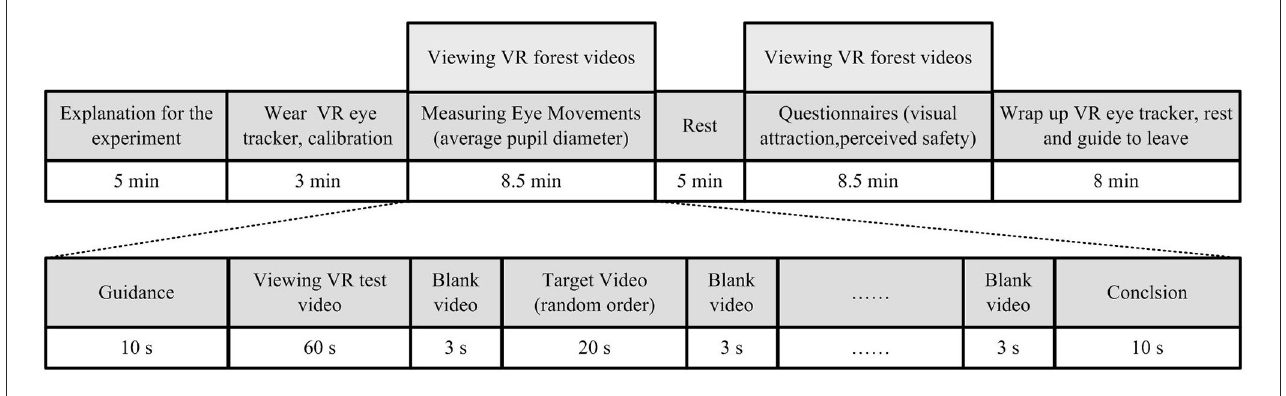
FIGURE5 Flow diagram of the experimental